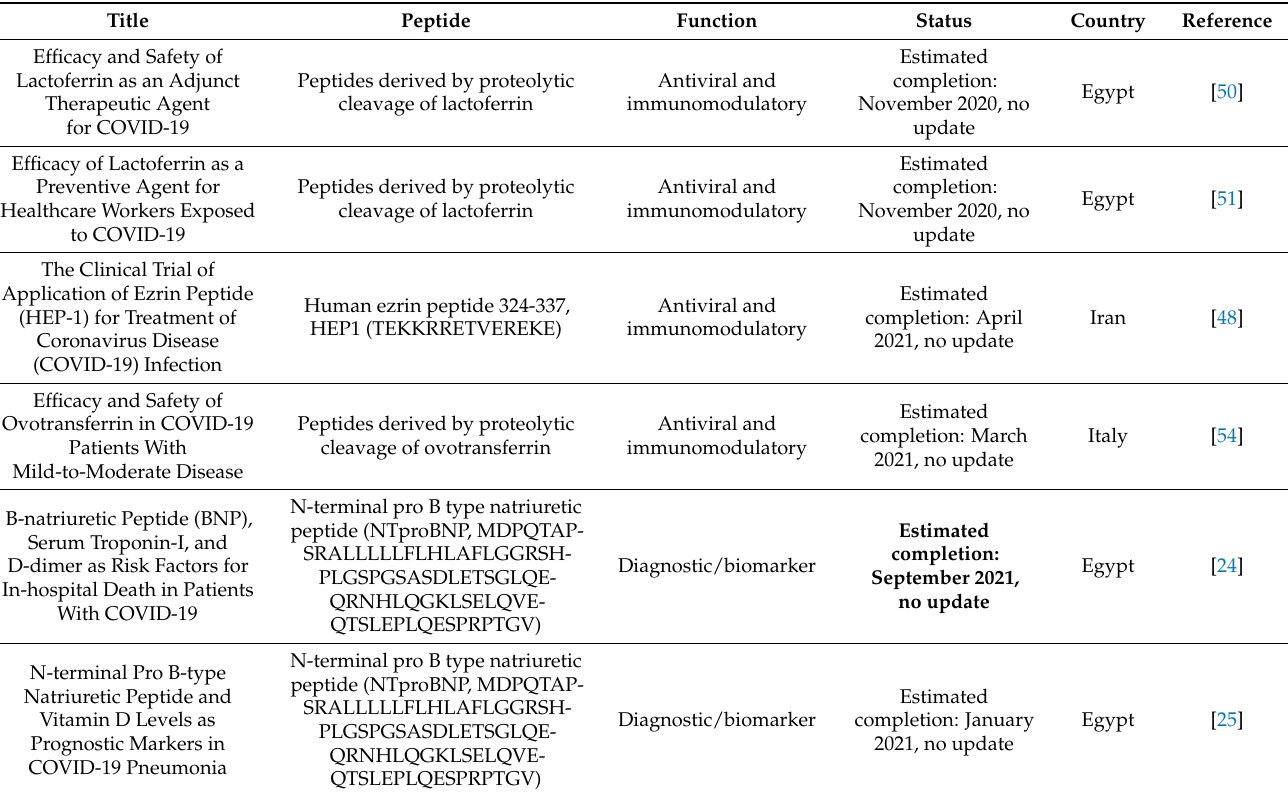
Table 1. Overview of 36 clinical trials according to information obtained from ClinicalTrials.gov. Bold indicates trials that are not yet finished according to the estimated finish